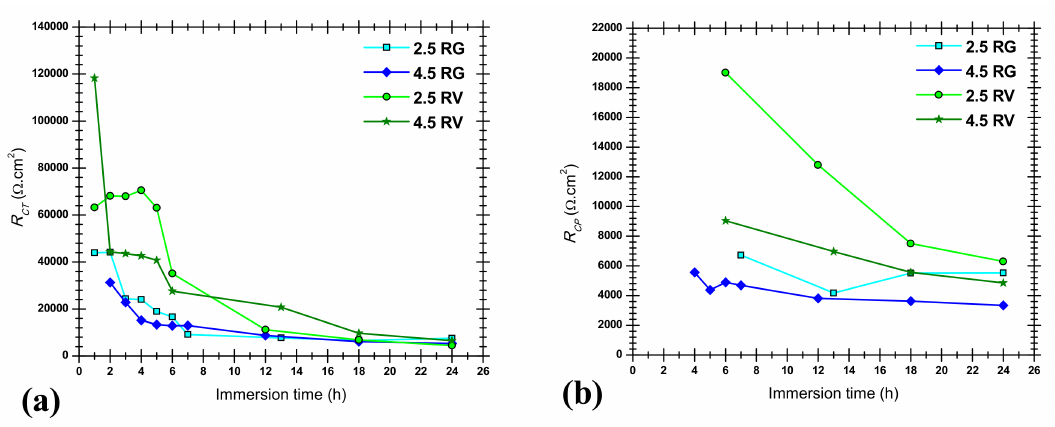
Figure 16. Fitted EIS parameters of as-cast thin wall samples: ( a ) R CT and ( b ) R CP .